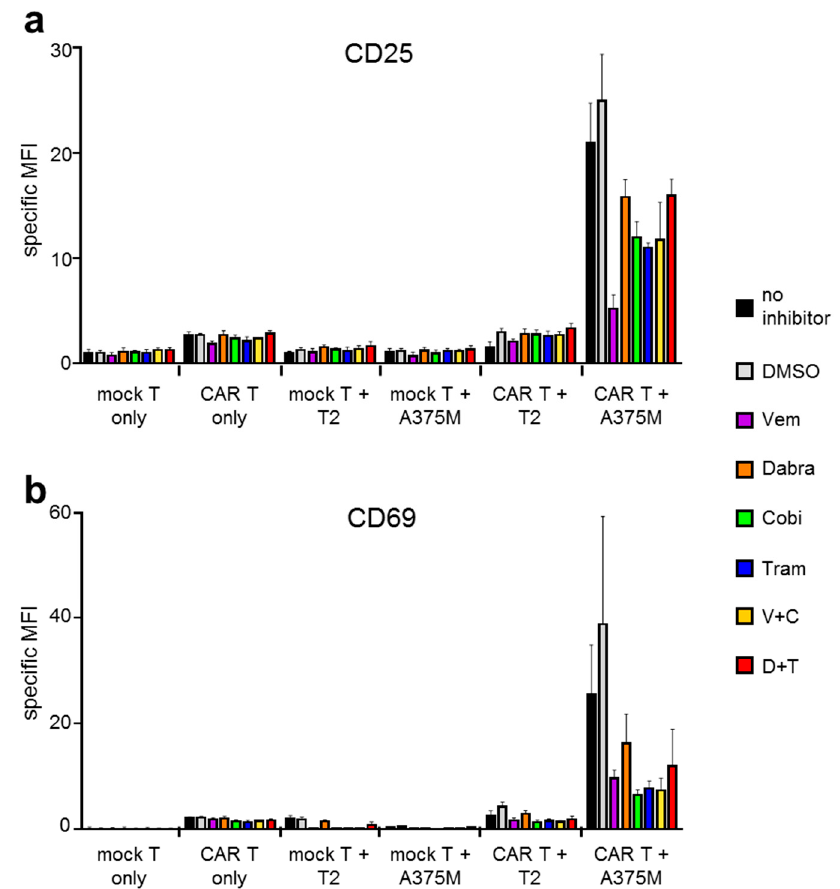
Figure 2. BRAF and MEK inhibitor treatment affects CAR-T-cell activation after antigen-specific stimulation. CAR-T cells were generated as described in Figure 1. Four hours after electroporation, these cells were co-incubated overnight with CSPG4-negative T2 cells and the CSPG4 + melanoma cell line A375M at a 1:1 ratio. Mock-transfected T cells were used as control. Co-incubations were performed in the absence of inhibitors (no inhibitor), in the presence of DMSO only (solvent control), or in the presence of the different kinase inhibitors, either alone or in combination. The used kinase inhibitors vemurafenib (Vem, V), dabrafenib (Dabra, D), cobimetinib (Cobi, C), and trametinib (Tram, T) were used in final concentrations listed in Table 1. Mock-transfected T cells (mock T) stimulated with T2 or A375M, and mock-transfected T cells and CAR-T cells incubated without target cells served as negative controls. After 16 h of co-incubation, the cells were harvested and stained for the activation markers CD25 ( a ) and CD69 ( b ) and measured by flow cytometry. The specific mean fluorescence intensity (MFI) of the respective activation markers on cells in the T-cell gate is depicted. The MFI was calculated by subtracting the value of the respective isotype control. Data are presented as mean + SEM derived from four independent experiments (original data see Table S2; for statistical analyses see Tables S3 and S4). Flow-cytometric data of a representative donor is shown in supplemental Figure S1.